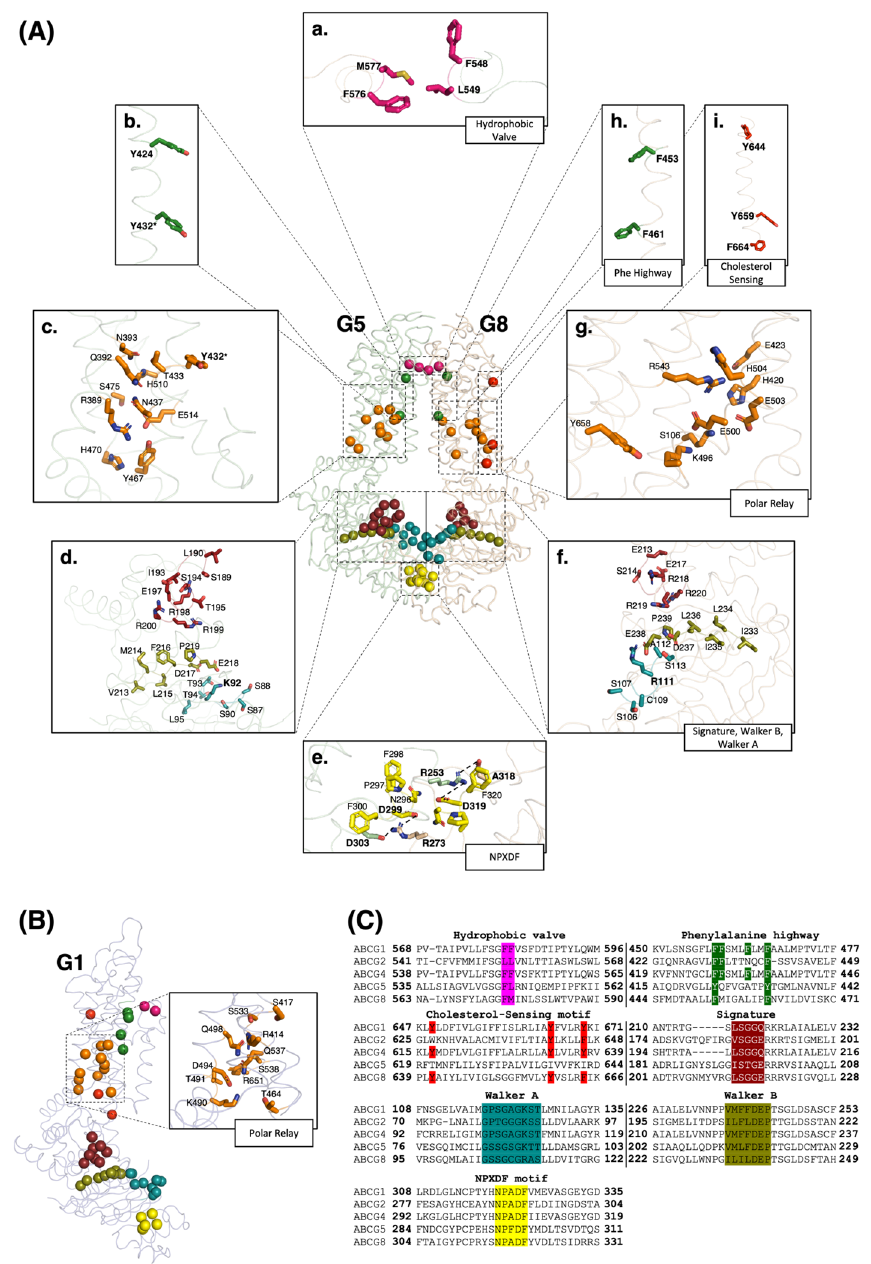
Figure 1. Motifs and elements in ABCG1 and ABCG5/G8. ( A ) Stick illustration of structural motifs shown on the crystal structure of ABCG5/G8 (PDB ID: 8CUB). ( a – i ) In the extracellular region, hydropho- bic valve residues are shown in pink; in the TMDs, phenylalanine highway, cholesterol-sensing motif, and polar relay are represented in green, red, and orange, respectively; in the NBDs, signature, Walker A, Walker B, and NPXDF motifs are illustrated in brick red, deep teal, deep olive, and yellow,